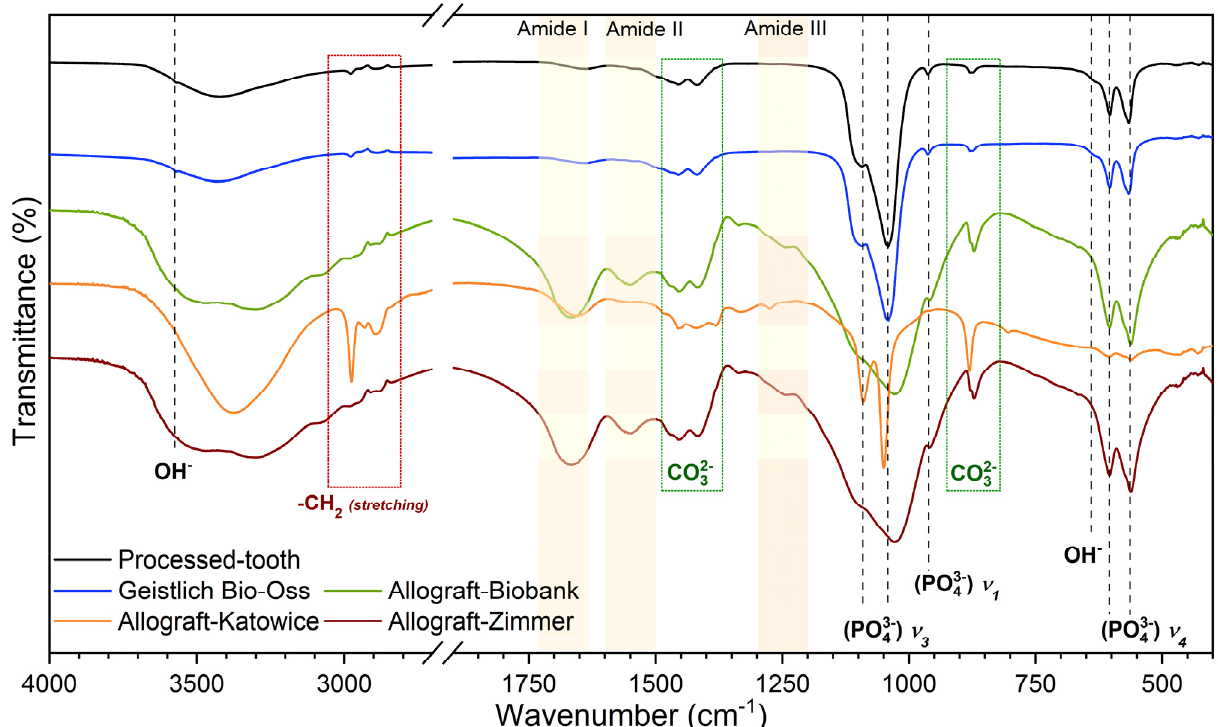
Figure 7. FT-IR spectra of investigated